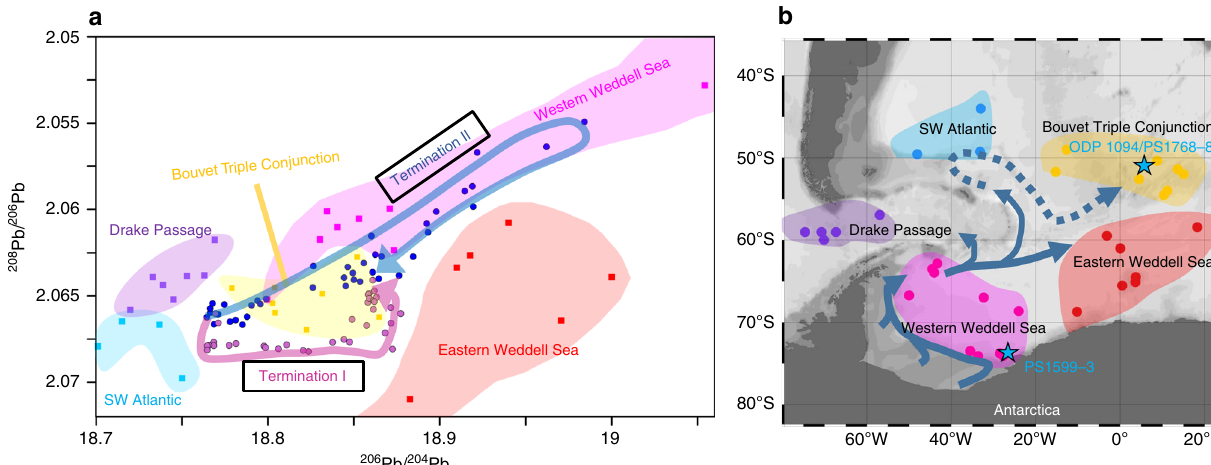
Fig. 3 206 Pb/ 204 Pb – 208 Pb/ 206 Pb trends during Terminations I and II. a Authigenic Fe – Mn oxyhydroxide-based Pb isotopic evolution observed at Site 1094 compared with Pb isotopic signatures in surface Fe – Mn nodules 72 and compositions extracted from core-top sediment samples in different parts of the Atlantic sector of the Southern Ocean shown in ( b ) (see the section “ Methods ” ). The regionally characteristic Pb isotopic signature for various regions is marked by different colors. The arrows delineate the Pb isotopic evolution across the last two glacial – interglacial transitions (Termination I arrow covers 18 ka − 12 ka BP and Termination II arrow covers 142 ka − 125 ka BP). b Locations of Fe – Mn nodules and core-top sediment samples (Supplementary Data 2). The blue arrows in ( b ) indicate the modern AABW circulation and export path. The dashed blue arrow traces the LCDW fl ow path after entrainment of Weddell Sea AABW 73 . Panel ( b ) created with Ocean Data View 71 . AABW: Antarctic Bottom Water; LCDW: Lower Circumpolar Deep